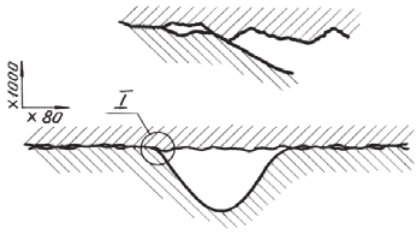
Fig. 10. The engagement of micro asperity projections with the edge of a micro groove in sliding friction The micro asperities located over micro grooves do not experience compression under load during the process of friction; hence, their height is greater than the height of micro asperities in the contact area between micro